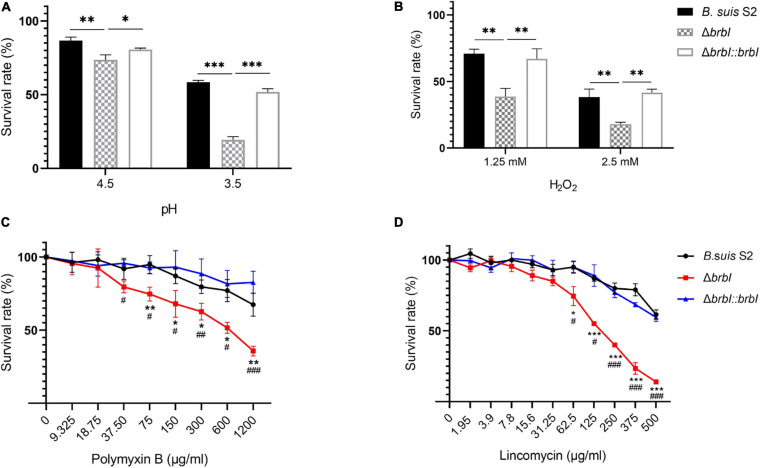
Role of BrBI on stress resistance in B. suis S2. Bacterial samples were inoculated into TSB containing HCl (A) for 30 min and H2O2
(B) for 1 h at 37°C. For antibiotic resistance, bacterial samples were seeded into a 96-well microplate and treated with serially diluted polymyxin B (C) and lincomycin (D) at 37°C for 1 h. After treatment, samples were diluted 10-fold and plated onto TSA plates to determine the survival rate of each strain by dividing the treated bacterial CFUs by the untreated bacterial CFUs. In panels C and D, “*” indicates comparison of the B. suis S2 and ΔbrbI strains; “#” indicates comparison of the ΔbrbI::brbI and ΔbrbI strains. The data are expressed as the mean ± SD of representative experiments performed in triplicate and analyzed using one-way ANOVA with Tukey’s post-test. */#p < 0.05, **/##p < 0.01, ***/###p < 0.001.